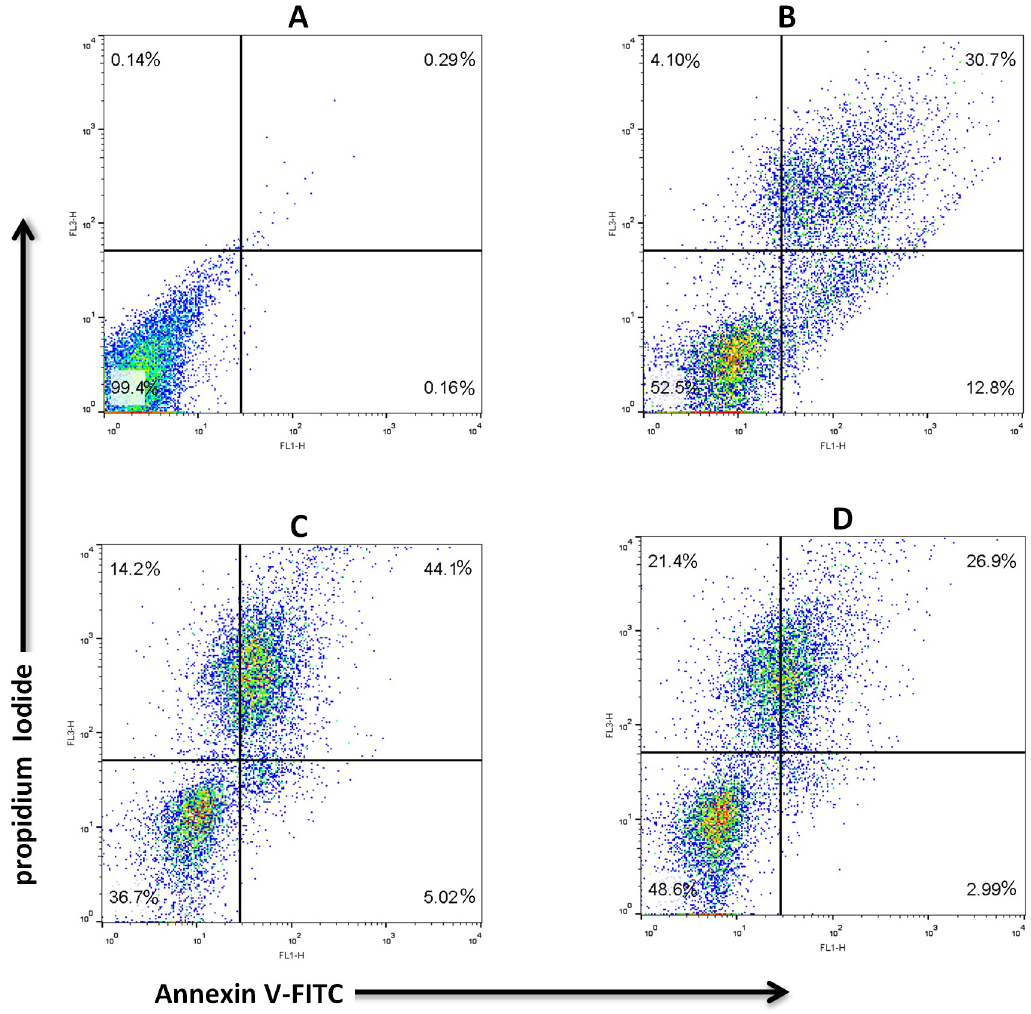
Fig 8. Annexin V and propidium iodide staining were used to determine the different cell populations. (A) Unstained sperm. (B) A fresh control. (C) A frozen control. (D) Frozen ELEF. The top left quadrant represents necrotic cells. The lower left quadrant shows live cells. The lower right quadrant and the top right quadrant show early apoptotic and late apoptotic cells, respectively.